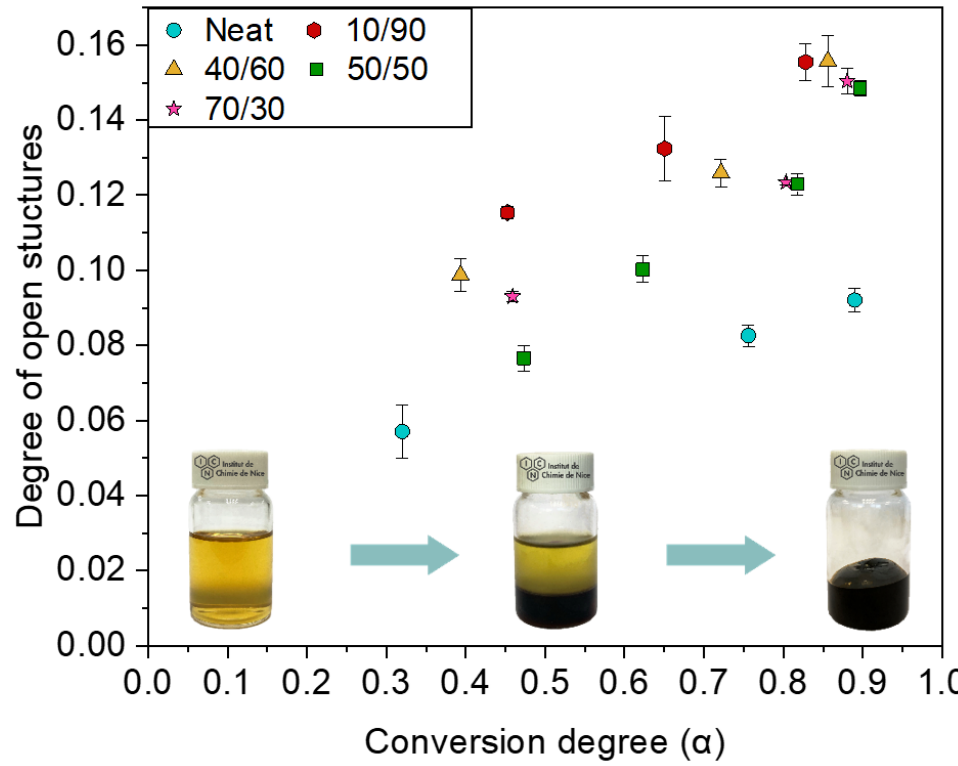
Figure 3. Comparison of the degree of open structures obtained with titration method and synthesized with different FA/Additional water ratios within function of the conversion degree.